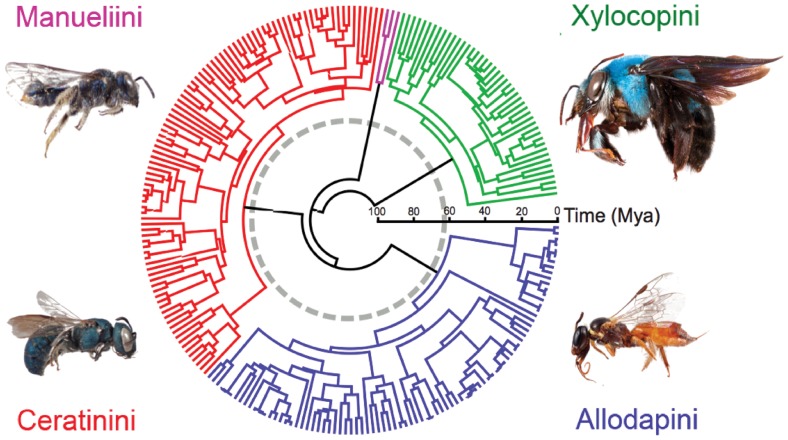
Chronogram from the BEAST uncorrelated log normal relaxed clock analysis.The outgroup, corbiculate apids, have been removed and the four Xylocopinae tribes are colour coded. The root node was set at 107Ceratina unimaculata (Ceratinini), Allodapula rozeni (Allodapini), Manuelia gayi (Manueliini) and Xylocopa sp. (Xylocopini).